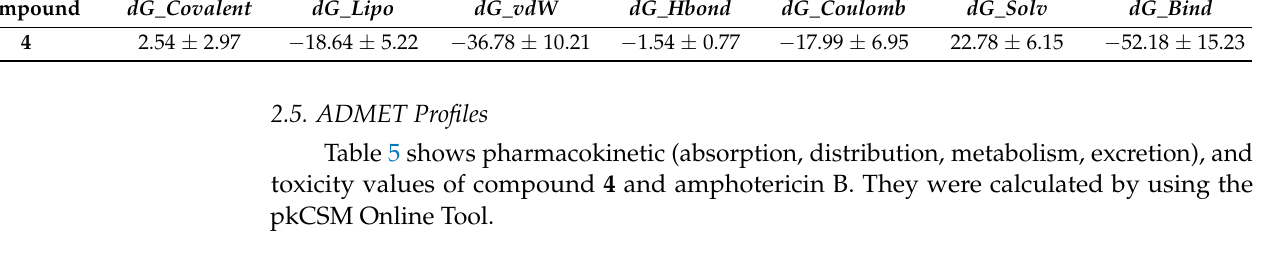
Table 5. ADMET properties of compound 4 and amphotericin